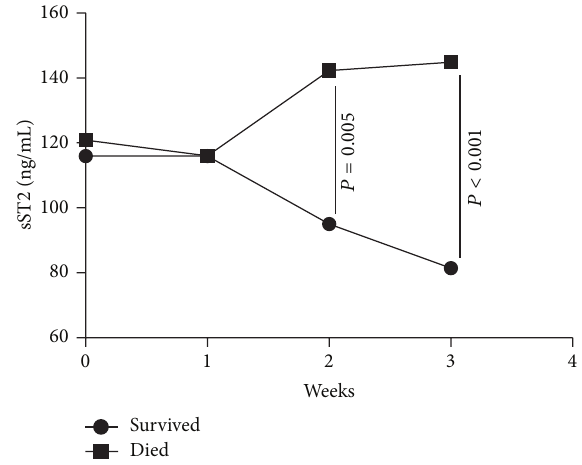
Figure 4: Dynamic changes in mean plasma levels of soluble ST2 (sST2) in patients who survived ( 𝑛 = 35 ) during the 180-day follow-up versus those who died ( 𝑛 = 13 ). Differences between the two groups at a single time point were evaluated using the Mann- Whitney 𝑈 test. Results of repeated measures analysis of variance confirmed that dynamic changes in sST2 levels of the two groups differed ( 𝑃 = 0.02 ).